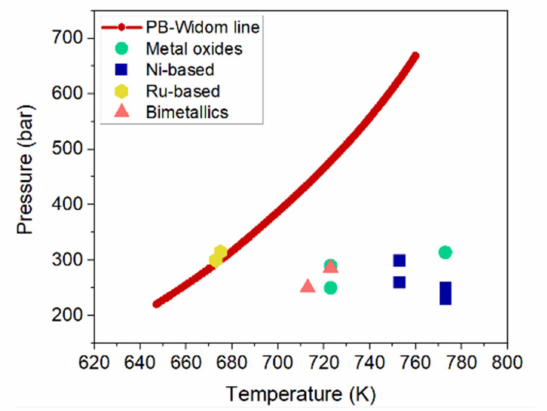
Figure 4. Selected optimal pressure-temperature conditions for SCWG processes over various catalysts; a selection taken from Tables 1 and 2 is presented relative to the PB-Widom line